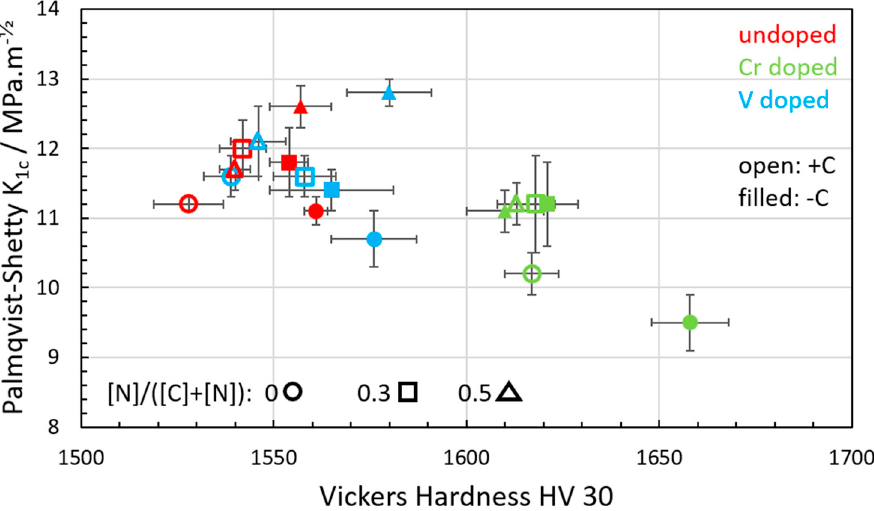
Figure 8. Palmqvist-Shetty fracture toughness K IC vs. Vickers hardness HV30 of 18 hardmetal grades as a function of nitrogen content [N]/([C]+[N]) of Ti(C,N) (circles: 0, squares: 0.3 and triangles: 0.5), doping (red: undoped, green: Cr doped) and C activity (open, filled symbols). The low C activity (“ − C”) is at Ms ≈ 75%, the high C (“+C”) at Ms ≈ 88%.